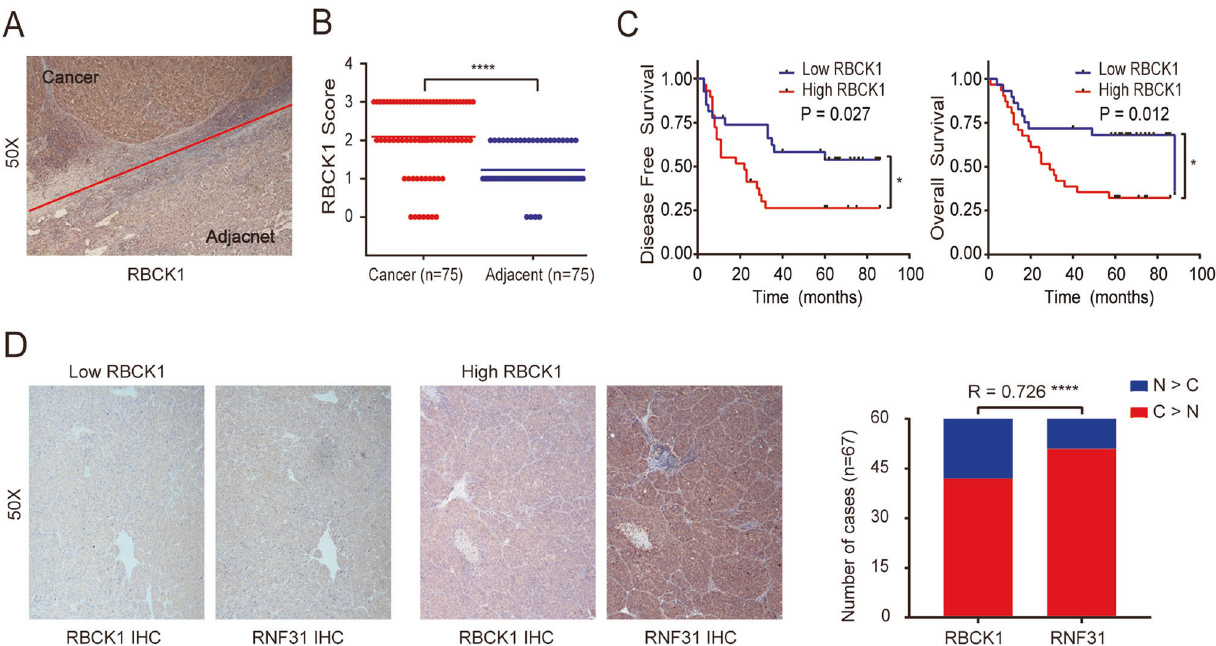
Fig. 7 RBCK1 expression was positively correlated with RNF31 expression in HCC tissues. A Typical IHC picture of RBCK1 in paired HCC and corresponding noncancerous liver tissues. B IHC assay was performed to detect RBCK1 expression levels in HCC tissues and adjacent noncancerous liver tissues. Immunohistochemical score were analyzed using Wilcoxon ’ s test ( n = 75, **** p < 0.001). C Overall survival and tumor-free survival of HCC patients were analyzed by Kaplan – Meier survival analysis (log-rank test, * p < 0.05). IHC staining was applied to divide the HCC patients into the high and low expression groups of RBCK1. D Representative images of immunohistochemical staining of RNF31 in HCC tissues with different expression levels of RBCK1. Correlation between RBCK1 and RNF31 protein levels in HCC tissues was analyzed by Spearman correlation analysis ( n = 67, R = 0.726, **** p <